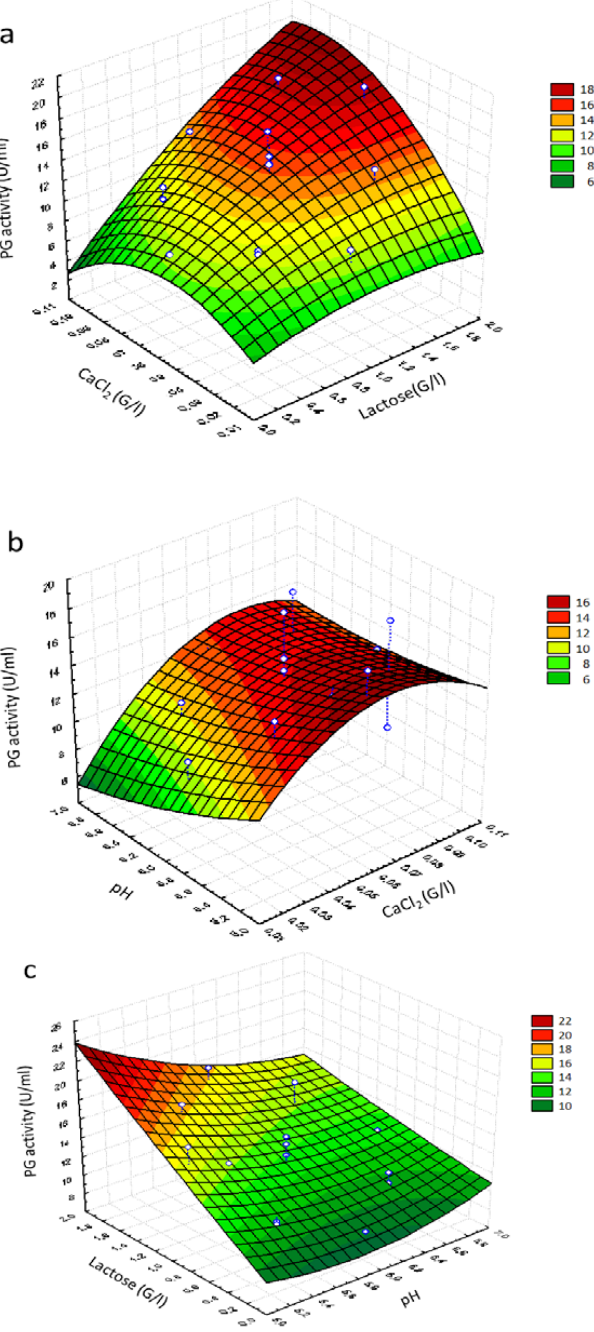
Figure 2. Response surface graphs of potentiation of PG activity by Aureobasidium pullulans showing the effect of variables of ( a ) Lactose–CaCl 2 , ( b ) pH–CaCl 2 , and ( c ) pH–Lactose.